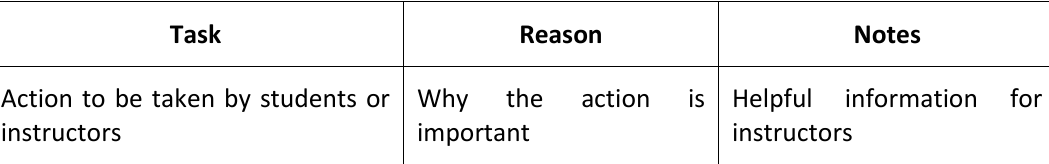
Fig.2. Activity template depicting information contained in every